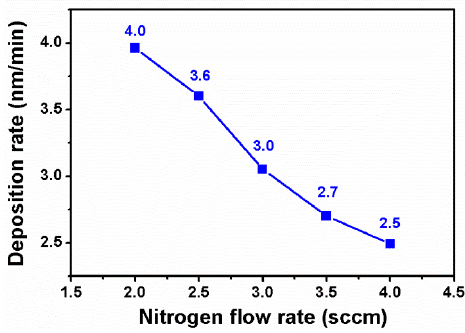
Figure 2. Deposition rates of Batch I Zr–Si–N films fabricated using various nitrogen flow rates. Figure 3 depicts the GIXRD patterns of the Zr–Si–N films. The Zr 52 Si 8 N 40 and Zr 48 Si 9 N 43 films displayed a face ‐ centered cubic (fcc) ZrN (ICDD 35 ‐ 0753) phase; the Zr 45 Si 10 N 45 films exhibited mixed fcc ZrN and X ‐ ray amorphous phases; and the Zr 44 Si 10 N 46 and Zr 43 Si 10 N 47 films were found to have an X ‐ ray amorphous phase. Although the differences in Si and N contents between these films were not large, the structure varied evidently. The films with Si content of less than 9 at.% and N content less than 43 at.% exhibited a fcc structure, while the films with Si and N contents above the limitations exhibited an amorphous phase ‐ dominated structure.